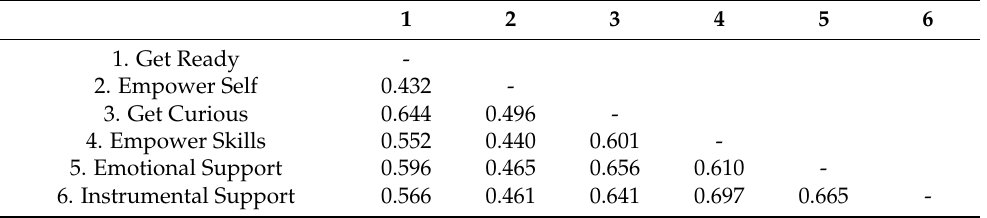
Table 2. Correlation among latent factors.